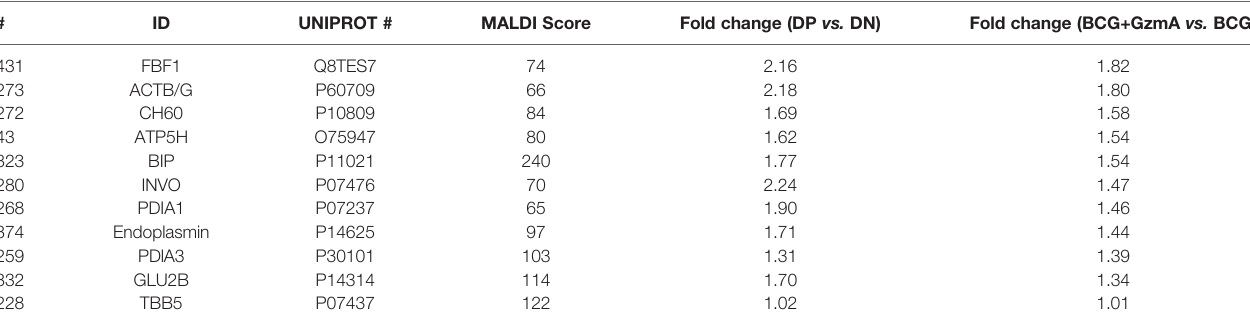
TABLE 2 | Global proteomic analysis uncovers several differentially abundant